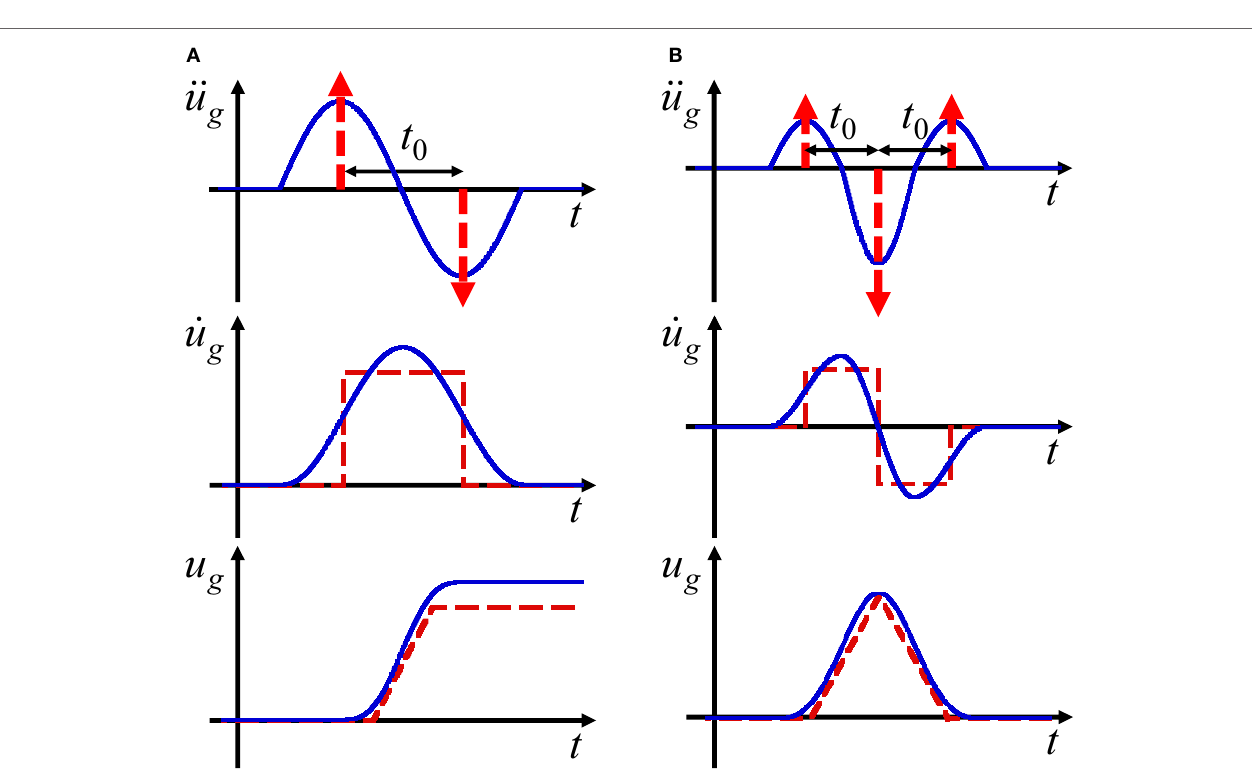
FIGURE 2 | Main part of near-fault ground motion, (A) fling-step input and double impulse, (B) forward-directivity input and triple impulse (Kojima and Takewaki, 2015a).